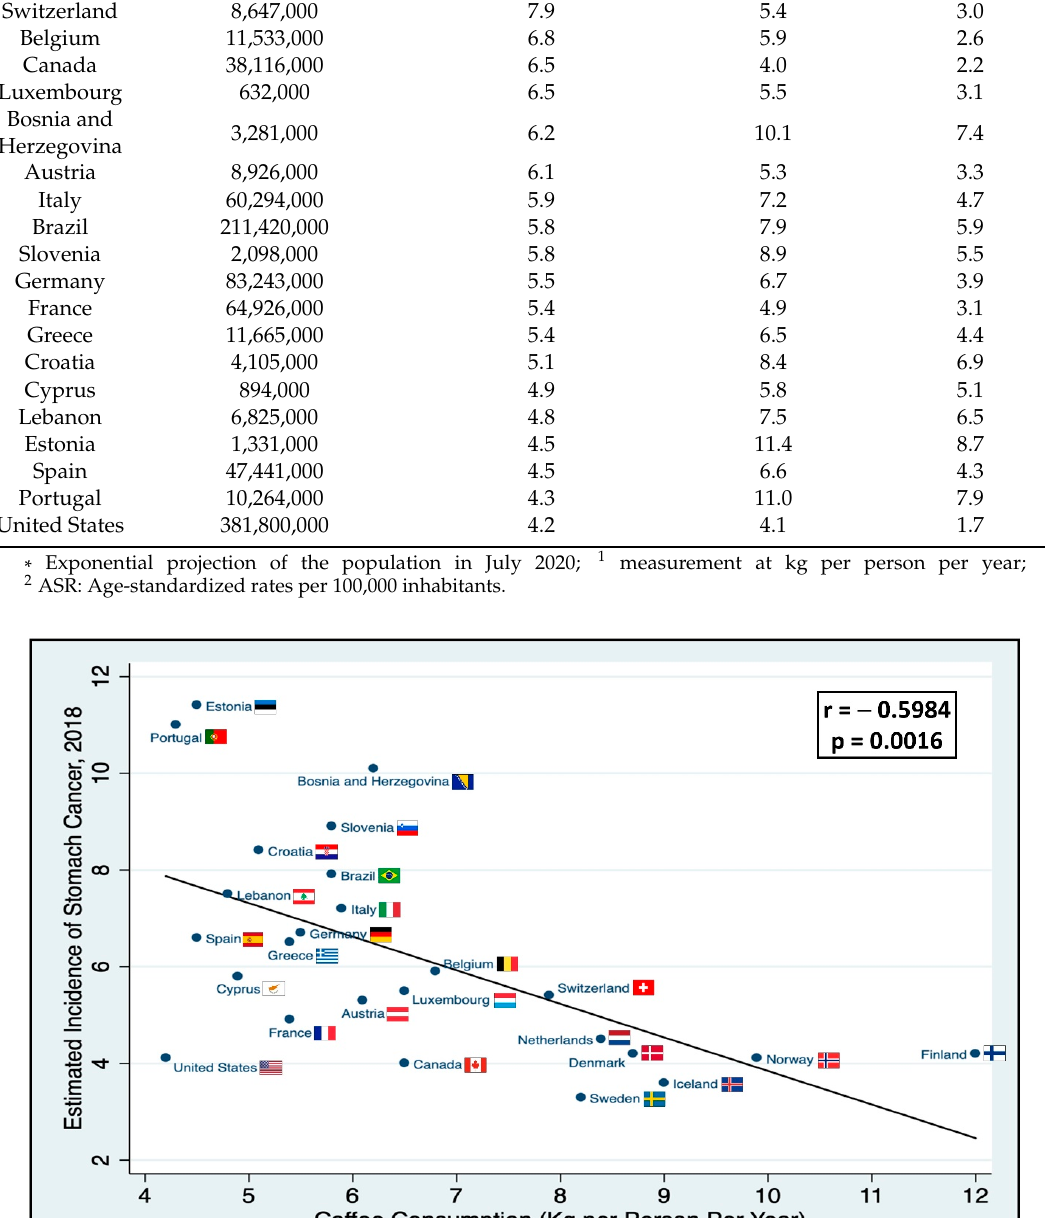
Figure 2. Coffee consumption and stomach cancer mortality. It shows the per country correlation between annual coffee consumption and the estimated age-standardized mortality of stomach cancer in 2018. Lineal model for mortality; mortality of stomach cancer = 7.78–0.54*(coffee consumption).